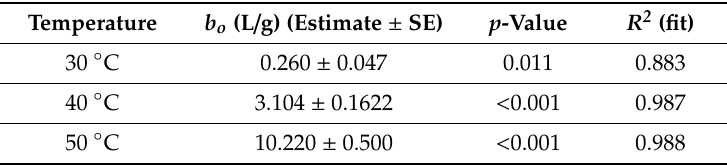
Table 4. Values for a linear fit with an intercept of the origin for each